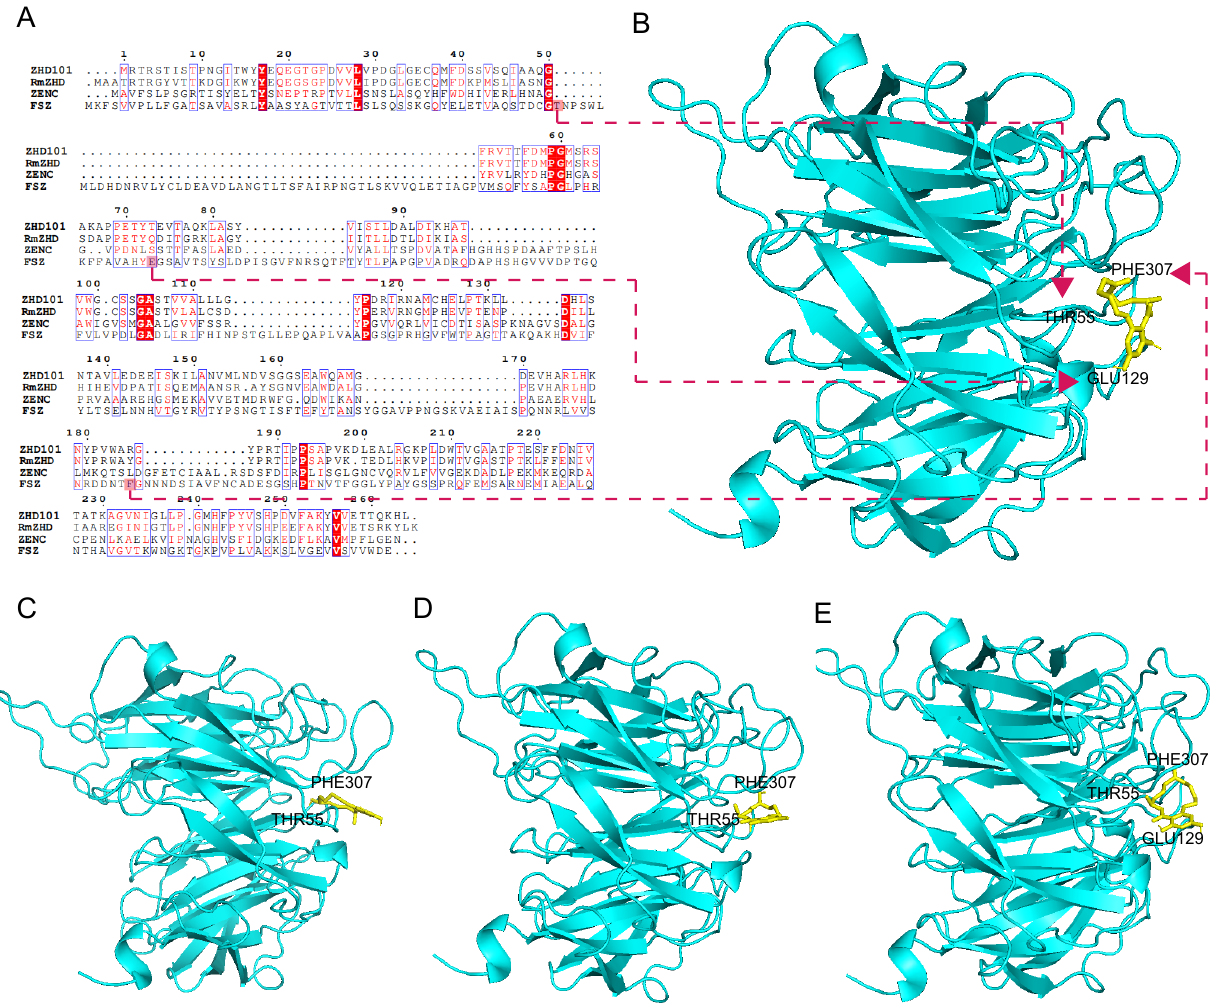
Figure 7. FSZ amino acid sequence alignment results and molecular docking of ZEN and derivatives: ( A ) amino acid sequence alignment of FSZ with other ZEN-degrading enzymes, ZHD101, RmZHD, and ZENC and FSZ amino acid sequence alignment; ( B ) molecular-docking results of FSZ and ZEN; ( C ) molecular-docking results of FSZ and α -ZAL; ( D ) molecular-docking results of FSZ and β -ZOL; ( E ) molecular-docking results of FSZ and